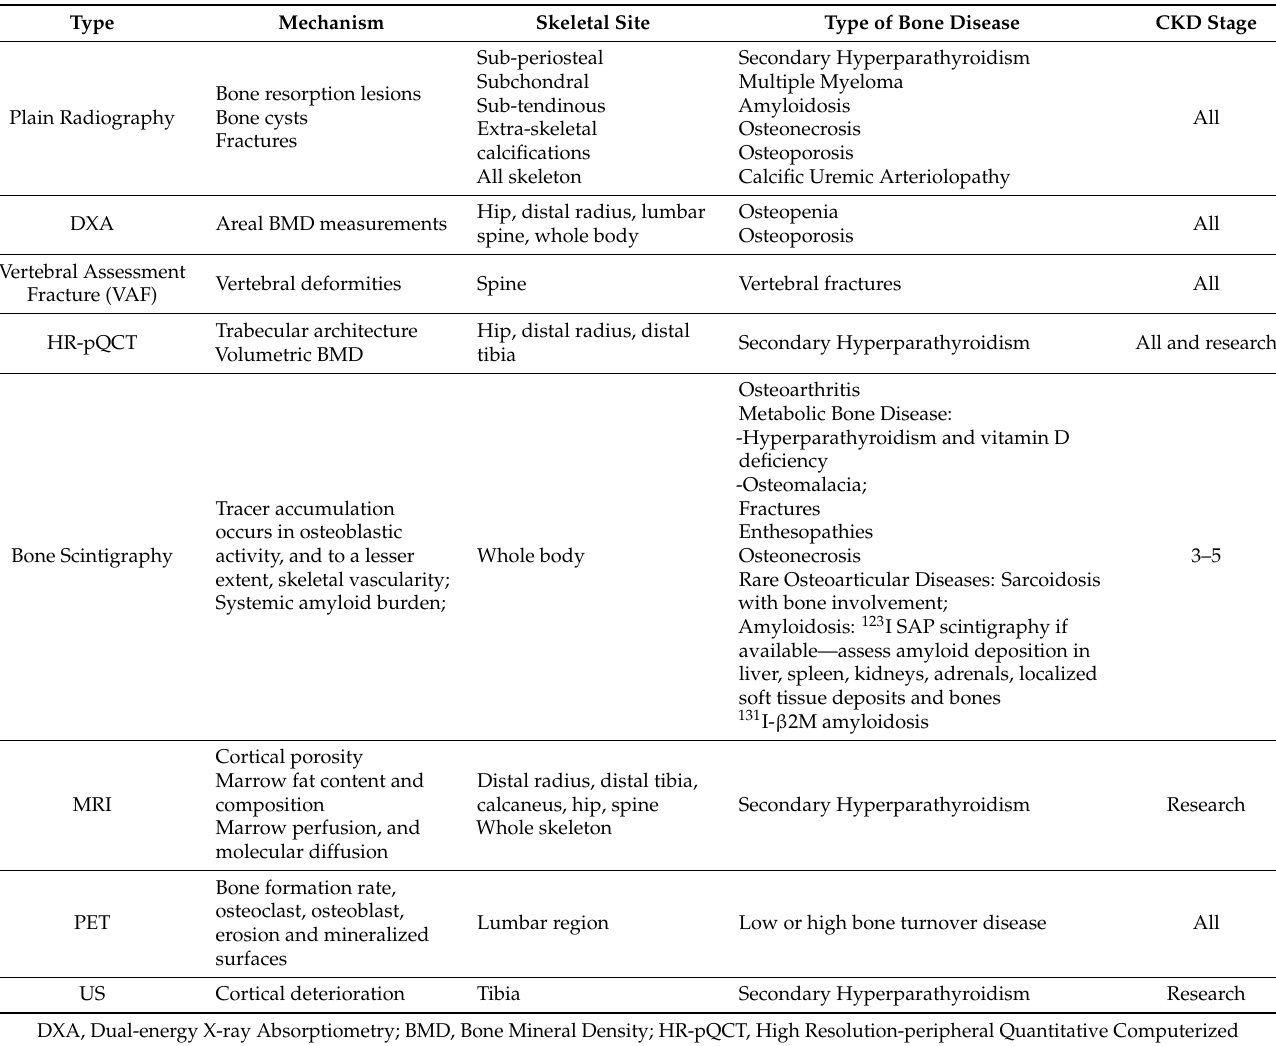
Table 1. Different imaging techniques, underlying lesion mechanisms and localization and CKD stage in which it is mostly